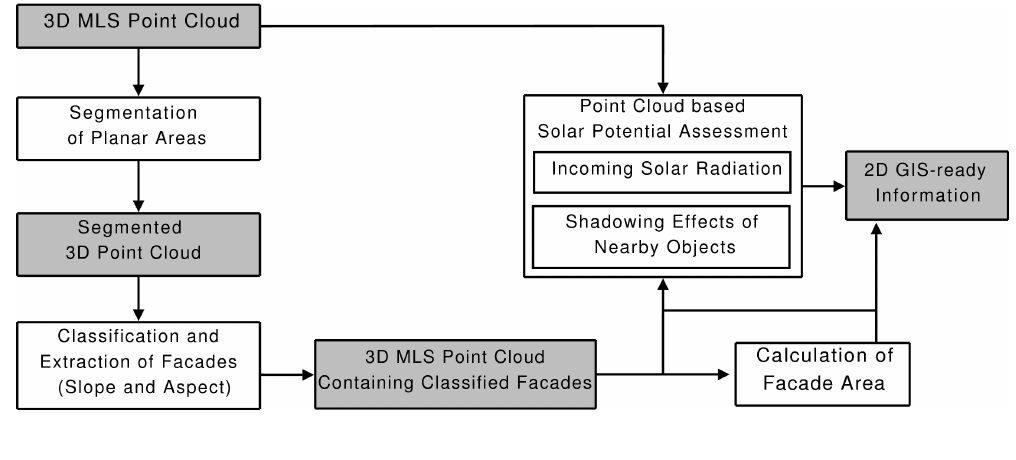
Figure 1. Workflow for point cloud based solar potential assessment of building